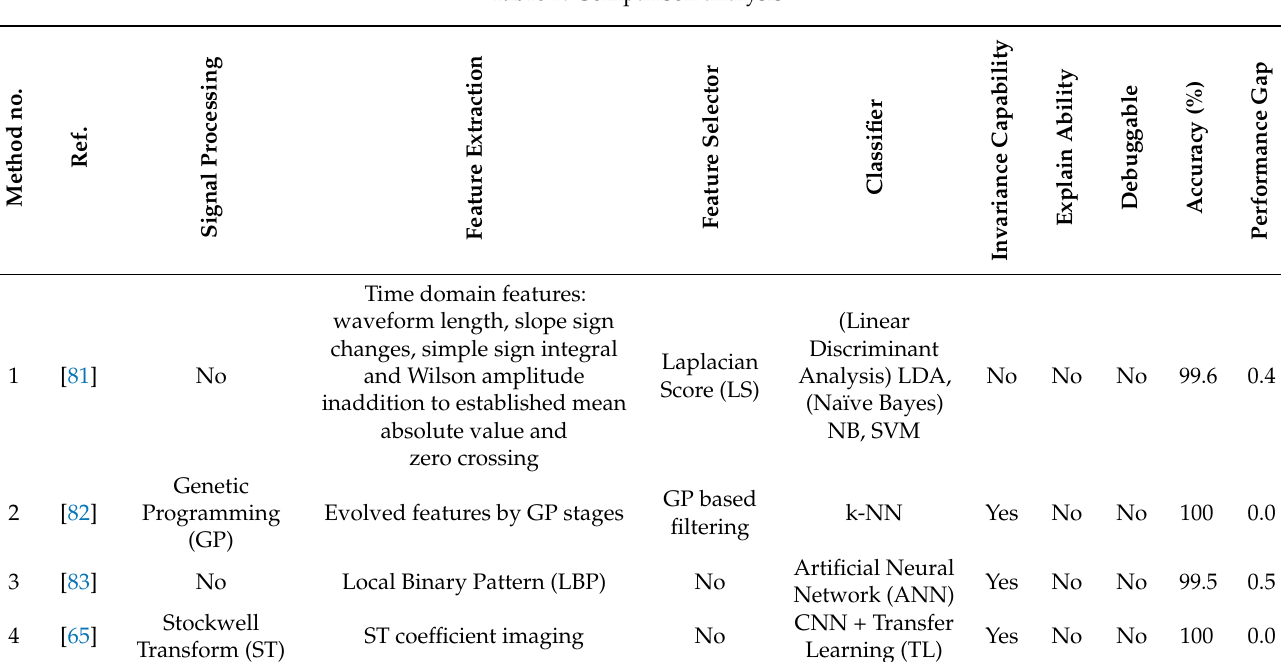
Table 7. Comparison